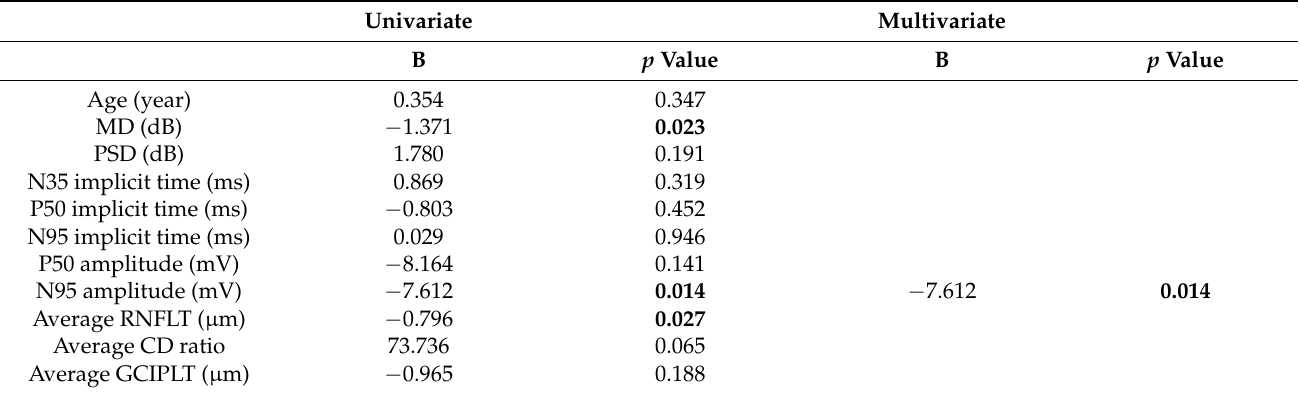
Table 4. Linear Regression Analysis evaluating the Factors associated with Circumparapillary Choroidal Microvasculature Dropout Angular Width in the subgroups of Eyes with Choroidal Microvasculature Dropout.